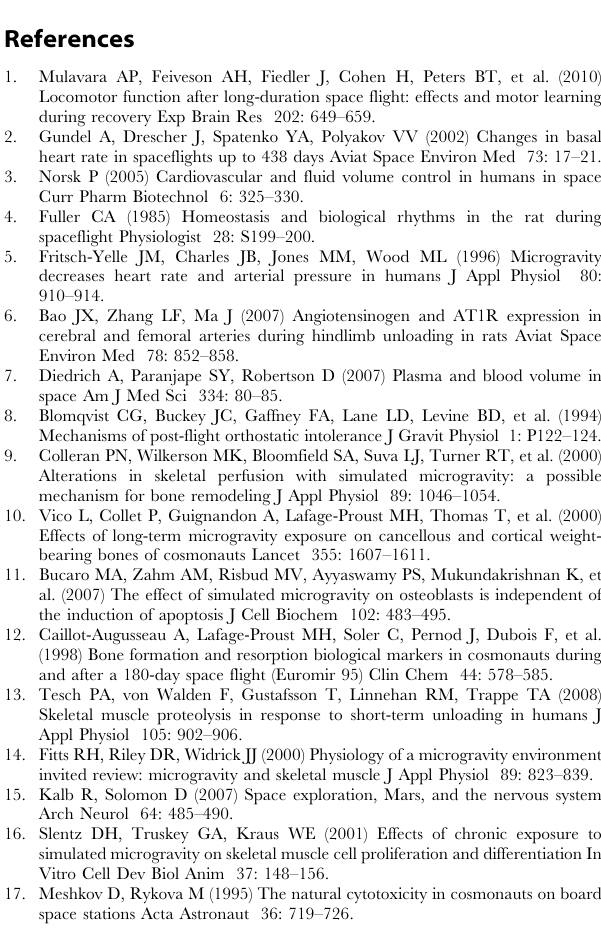
Table S1 On-orbit activities. Activities on the ISS began on September 1 st , 2009, four days after the launch of the Shuttle Discovery. (DOC) Table S2 Tissue Sharing Program (TSP) . Tissue Sharing Program (TSP) involved investigators and tissues they are interested in. (DOC) Table S3 Acronyms. Acronyms reported and their meaning. (DOC) Video S1 Mouse behavior during flight experiment daily observation. Mouse behavior inside MDS cage during flight daily observation. (AVI) Video S2 Mouse behavior upon landing. Mouse Wt2 behavior immediately after extraction from MDS payload upon landing.